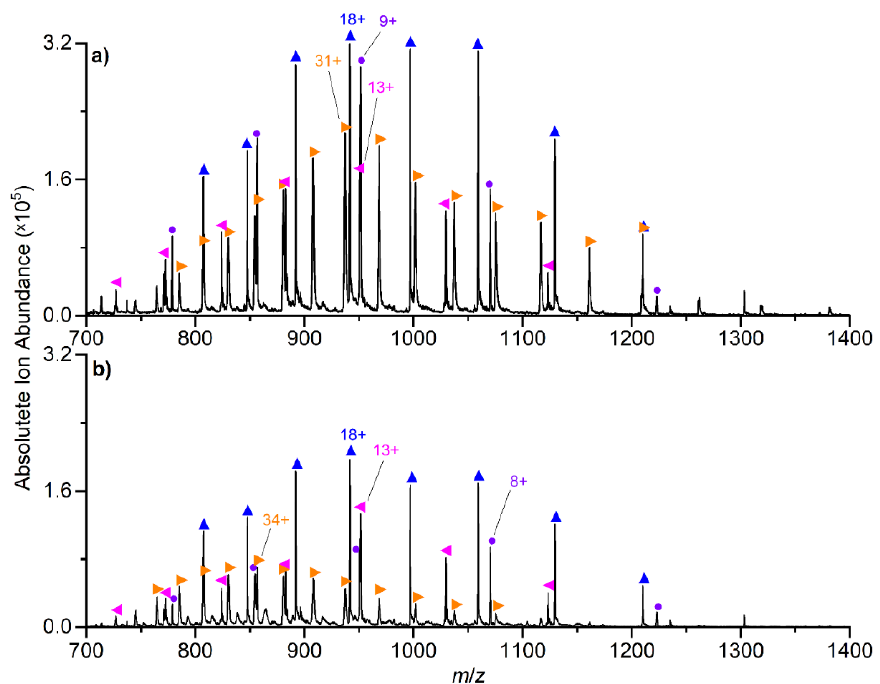
Figure 5. Pulsed ( a ) and direct current nESI ( b ) mass spectra of a mixture of ubiquitin (●), cytochrome C ( ◄ ), myoglobin ( ▲ ), and carbonic anhydrase II ( ► ) formed from a solution containing 20 µM of each protein. The frequency and duty cycle of the pulsed high voltage was 200 kHz and 60% respectively. Table 2. Most abundant charge state, ion count of the most abundant charge state (arbitrary units), percentage increase in ion count, and average charge state of ubiquitin, cytochrome C, myoglobin, and carbonic anhydrase II obtained from pulsed and conventional direct current nESI mass spectra of a solution mixture containing all four proteins. Refer to Figure 5 for the corresponding mass spectra.